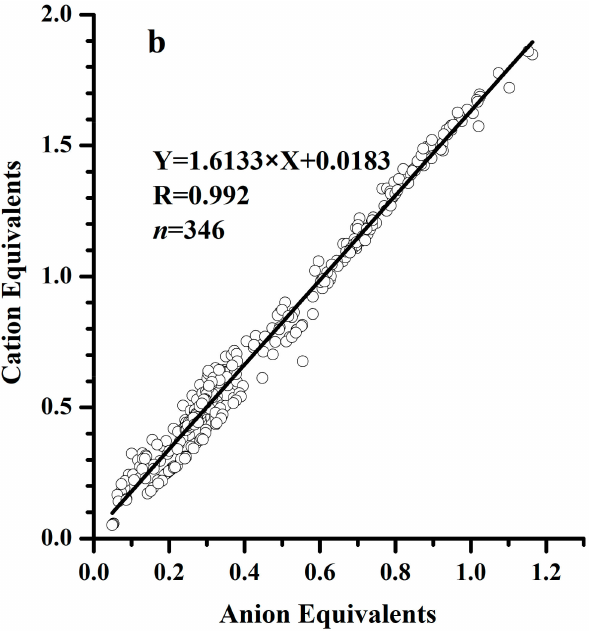
Figure 2. The equivalent concentrations of cations and